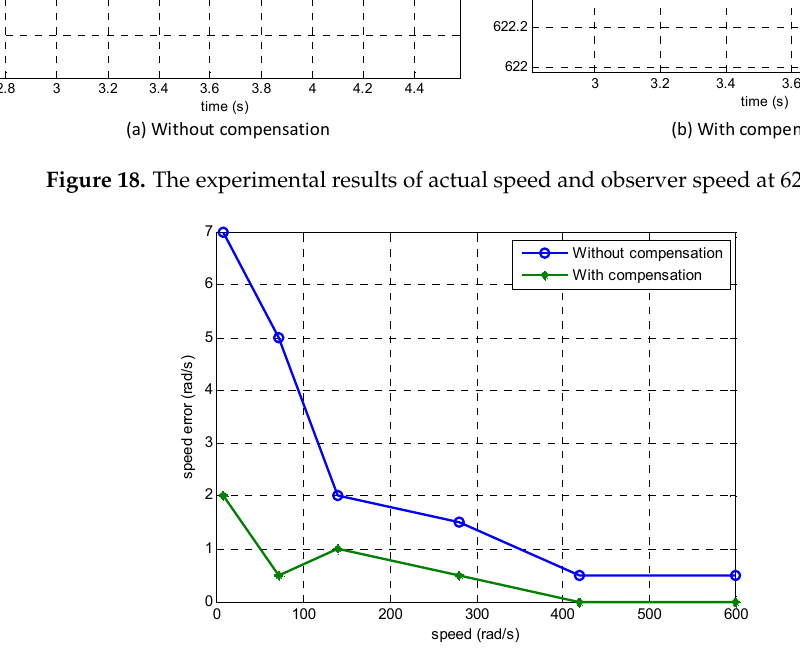
Figure 19. The speed errors of observer speed without and with the proposed compensation.